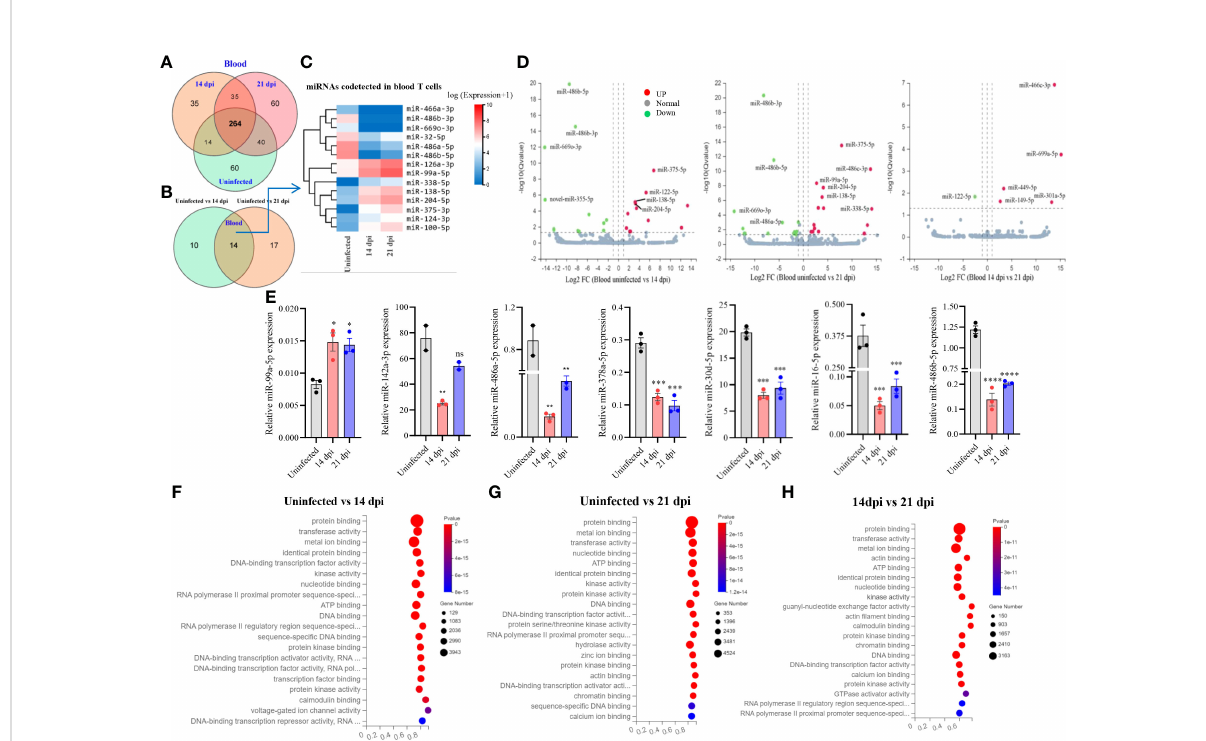
FIGURE 2 Blood T cell miRNA pro fi les, expression validation and prediction of molecular functions of their targets. (A) Venn diagram showing total and co-detected blood T cell miRNAs among uninfected, 14 dpi and 21 dpi groups (the number indicates the common or speci fi c miRNAs identi fi ed in different groups); (B) Venn diagram showing codetected and speci fi c blood T cell miRNAs between two groups (uninfected vs 14 dpi and uninfected vs 21 dpi); (C) Heatmap showing differentially expressed blood T cell miRNAs co-detected between two groups (uninfected vs. 14 dpi and uninfected vs. 21 dpi); (D) Volcano plot showing differentially expressed blood T cell miRNAs for different comparative analyses (uninfected control vs 14 dpi; uninfected control vs 21 dpi; 14 dpi vs 21 dpi). Green dot indicates downregulated miRNAs, red dot indicates upregulated miRNAs and grey dot indicates no signi fi cantly expressed miRNAs; (E) Validation of increased and decreased expressions of miRNAs of blood T cells by RT-qPCR. Data illustrate representative results and show the mean and standard error mean from an experiment carried out in triplicate. Statistical analysis was performed comparing uninfected vs 14 dpi or 21 dpi using one-way ANOVA and * denotes P ≤ 0.05, ** denotes P ≤ 0.01, *** denotes P ≤ 0.001, **** denotes P ≤ 0.0001 and ns denotes non-signi fi cant; (F – H) GO enrichment analyses of molecular functions of targets for differently expressed miRNAs (Uninfected vs 14 dpi (F) ; Uninfected vs 21 dpi (G) ; 14 dpi vs 21 dpi (H) in blood T cells). The results showing 20 most signi fi cantly enrichment functions of targets for differentially expressed